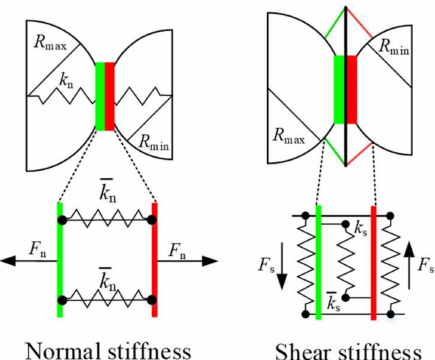
Figure 6. Schematic of parallel-bonded model. k n and k s are the normal and shear stiffnesses of particles, respectively; R max and R min are the large and small particle radii in two intercontacting particles, respectively; F n and F s are the normal and shear contacting forces between particles, respectively; k n and k s are the normal and shear stiffnesses of parallel bonding particles,